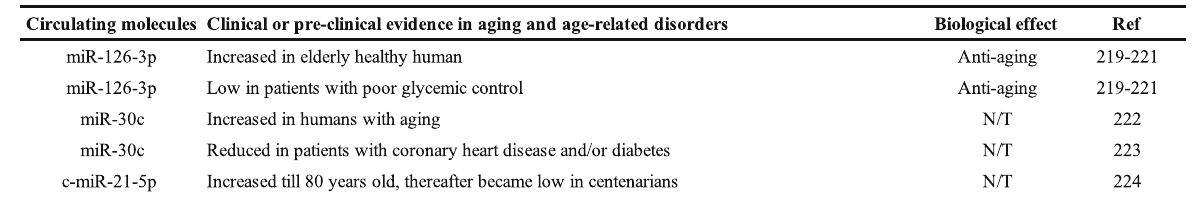
Table 3 The dynamics, clinical or pre-clinical evidence, and biological effect of circulating miRNAs in aging and age-related